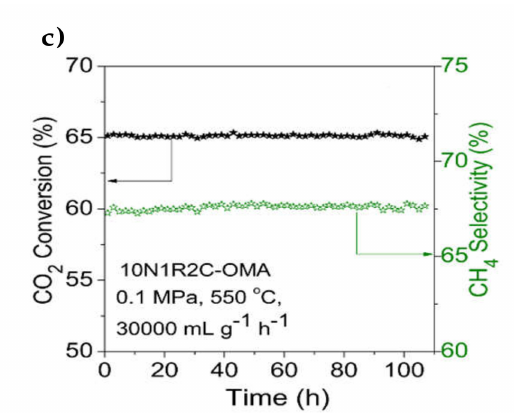
Figure 5. Catalytic properties of the prepared catalysts: ( a ) CO 2 conversion and ( b ) CH 4 selectivity; ( c ) lifetime test of the 10N1R2C-OMA catalyst. Reproduced with permission from ref. [75]. Copyright 2018